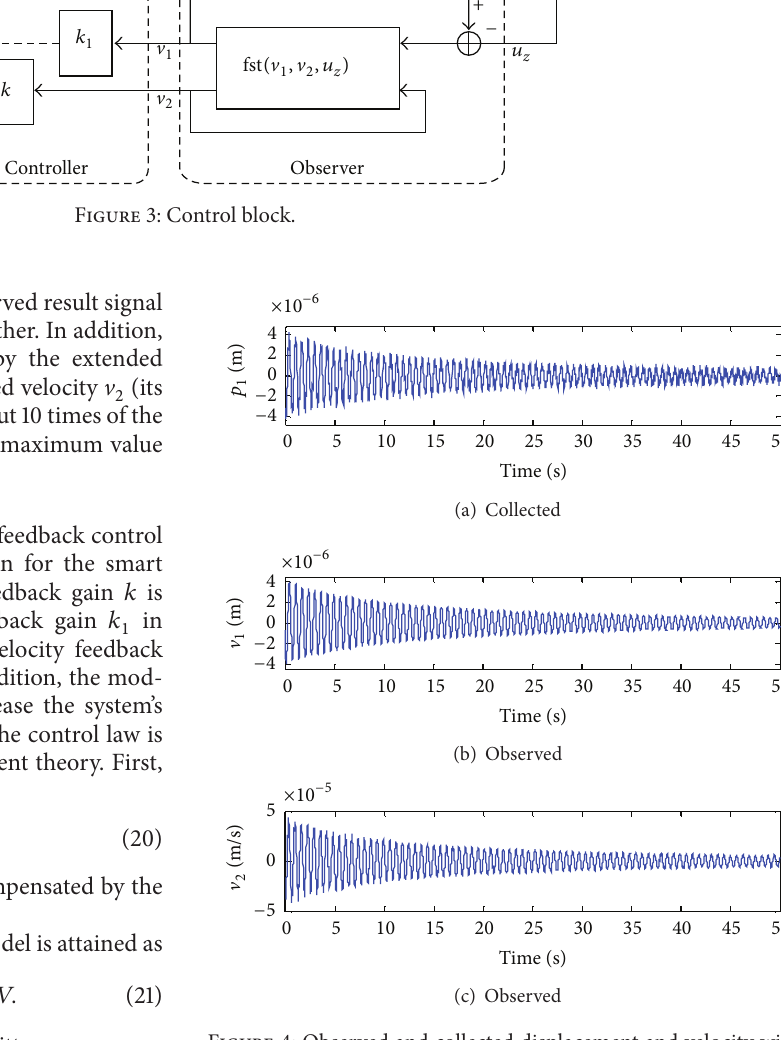
Figure 4: Observed and collected displacement and velocity with- out control.